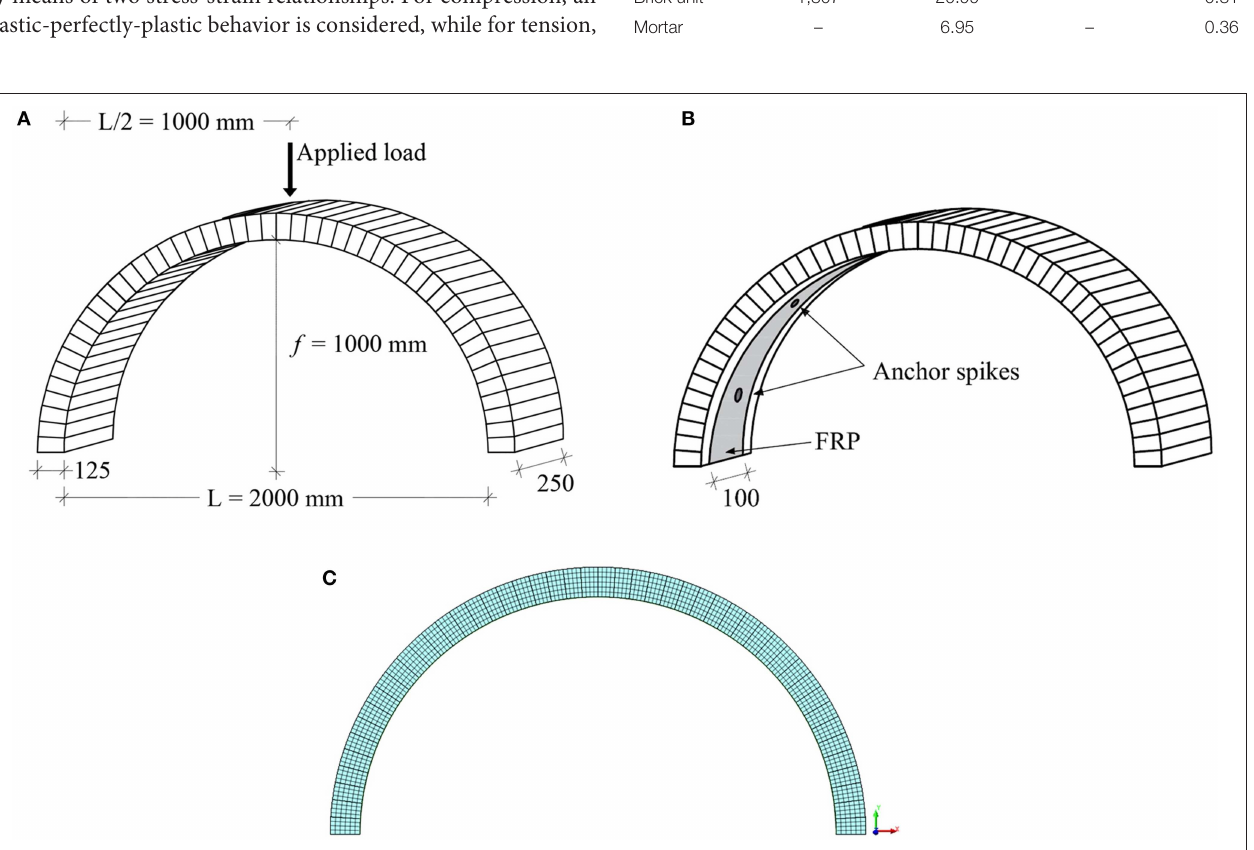
Frontiers in Built Environment |